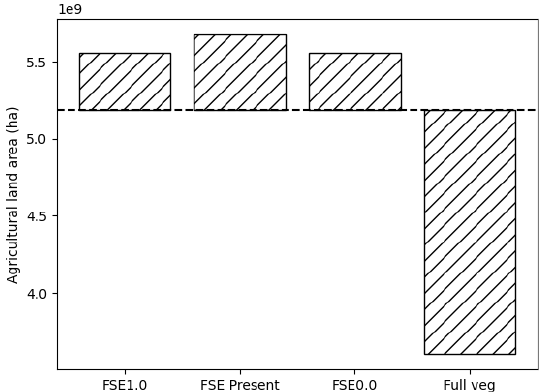
Figure 6. Change in 2050 agricultural land use between the anchor scenario (dotted line), maximum, present, minimum efficiency, and full-vegetarian diet scenarios. Maximum and minimum efficiency scenarios are produced by setting the food-system efficiency param- eter to 1.0 and 0.0, respectively, for all countries. The full-vegetarian diet scenario tends toward zero meat consumption globally by 2050. Dairy products are still consumed.